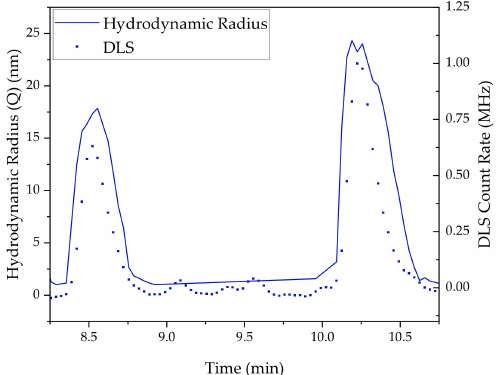
Figure 22. Course of the hydrodynamic radius (blue line), which results from the DLS signal (blue dots) of the slug over